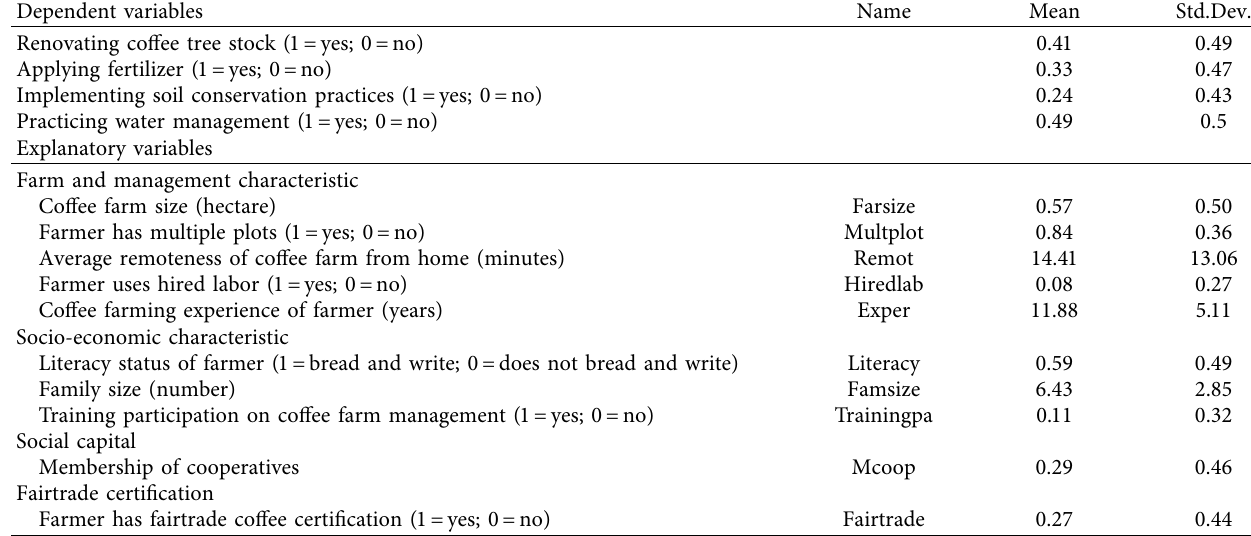
Table 1: Definitions of variables and descriptive statistics.